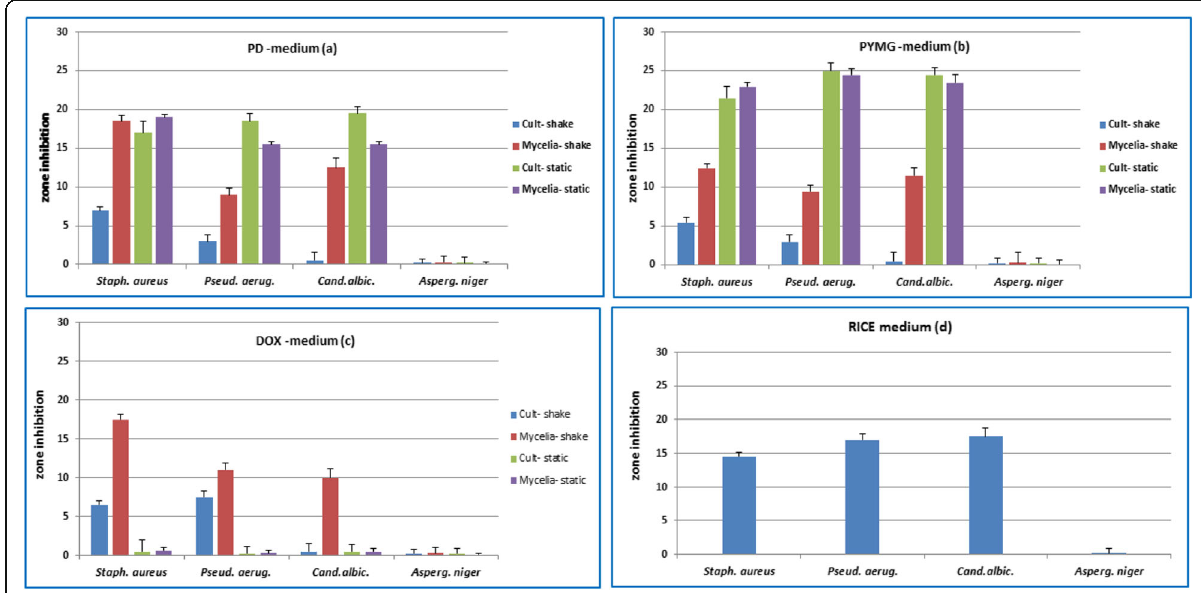
Fig. 1 Antimicrobial activity of secondary metabolite extracts from culture and mycelia (static and shake) of different media. Values are expressed as mean ± SD, n = 3 (200 μ g/ml for all tested